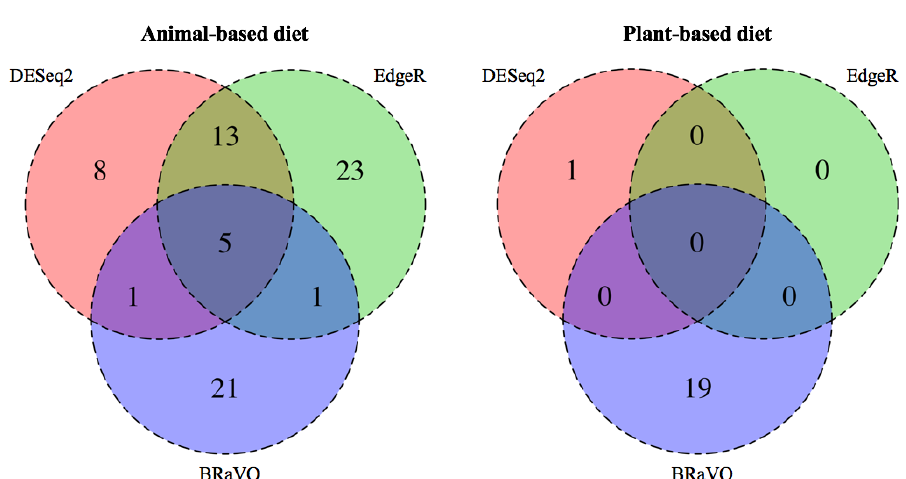
Figure 3. Comparison among outliers detected by three differential abundance analyses. This diagram shows the overlap among outliers detected by EdgeR, DESeq2, and BRaVO. The number in each color shade shows the total amount of outliers detected by each method. In the animal-based diets, BRaVO, EdgeR, and DESeq2 detected 28, 27, and 42 outliers, respectively. Among these outliers, 21 were detected only by our approach. In the plant-based diet group, BRaVO and DESeq2 detected 19 outliers and 1 outlier, respectively. EdgeR could not detect any significant outliers in this diet group. Therefore, there is no overlap of detected outliers in the three